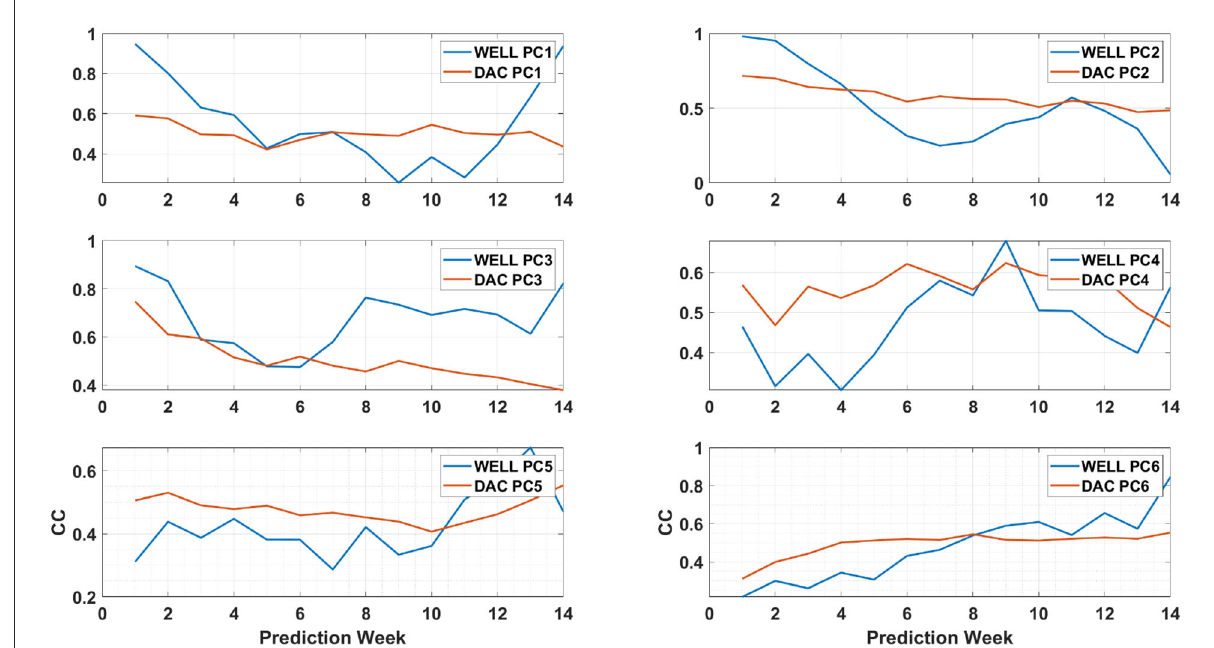
FIGURE13 Same as Figure 12 for eddy